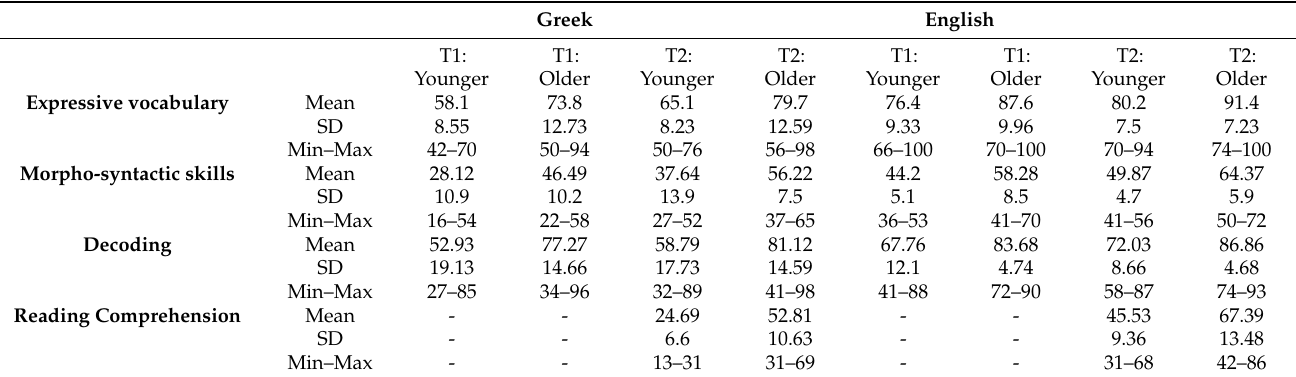
Table 1. Descriptive statistics of the bilingual children’s performance on the Greek and English expressive vocabulary, morpho-syntax and decoding (real-words, pseudo-word) and reading comprehension tasks (percentage correct) at Time 1 and Time